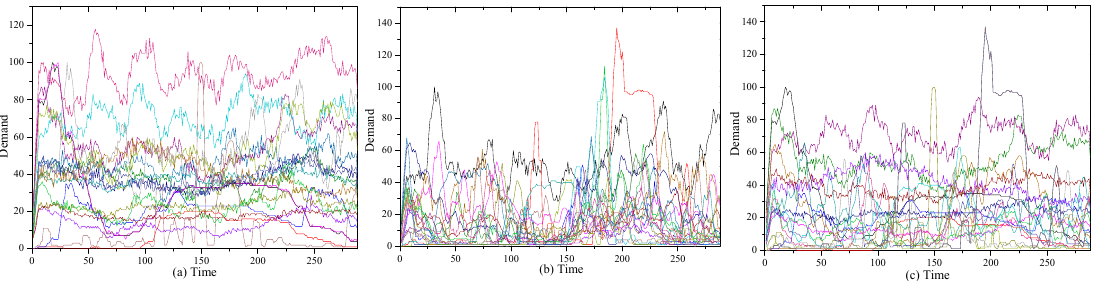
Figure 2. The resource demand patterns in ( a ) MIX0; ( b ) MIX1; and ( c ) MIX2.